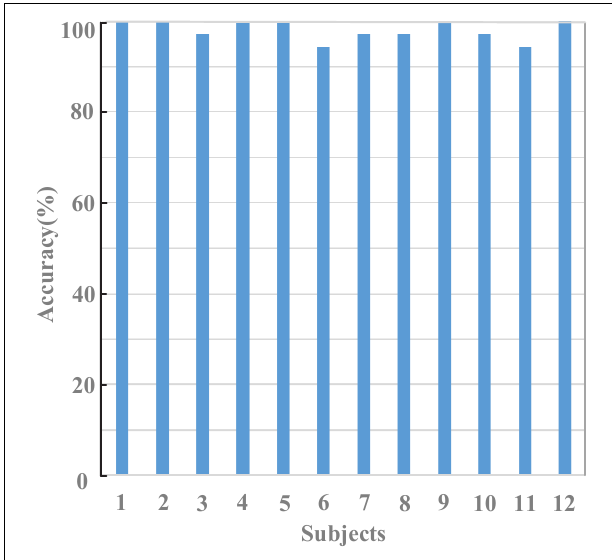
FIGURE 7 | The averaged accuracies in a random prompt experiment.